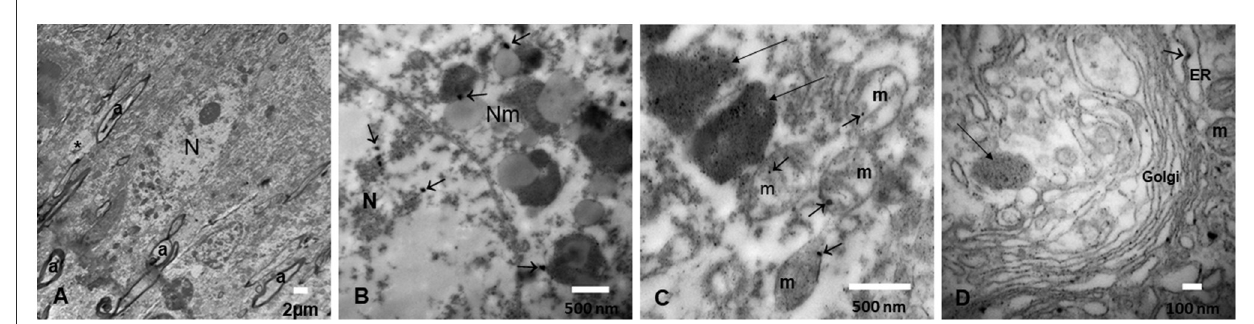
FIGURE7 (A) Locus coeruleus (LC) neuron surrounded by loose neuropil (*) and myelinated axons (a). (B) An LC neuron with neuromelanin (Nm) structures containing nanoparticles (arrows) and similar NPs identified inside the nucleus (N). (C) Numerous NPs are identified both in large endolysosomal structures (long arrows) and in mitochondria (m) (short arrows). (D) The Golgi apparatus is a target of NPs, as well as the endoplasmic reticulum dilated structures (ER) (short arrows) and the lysosomal structures (long arrows).